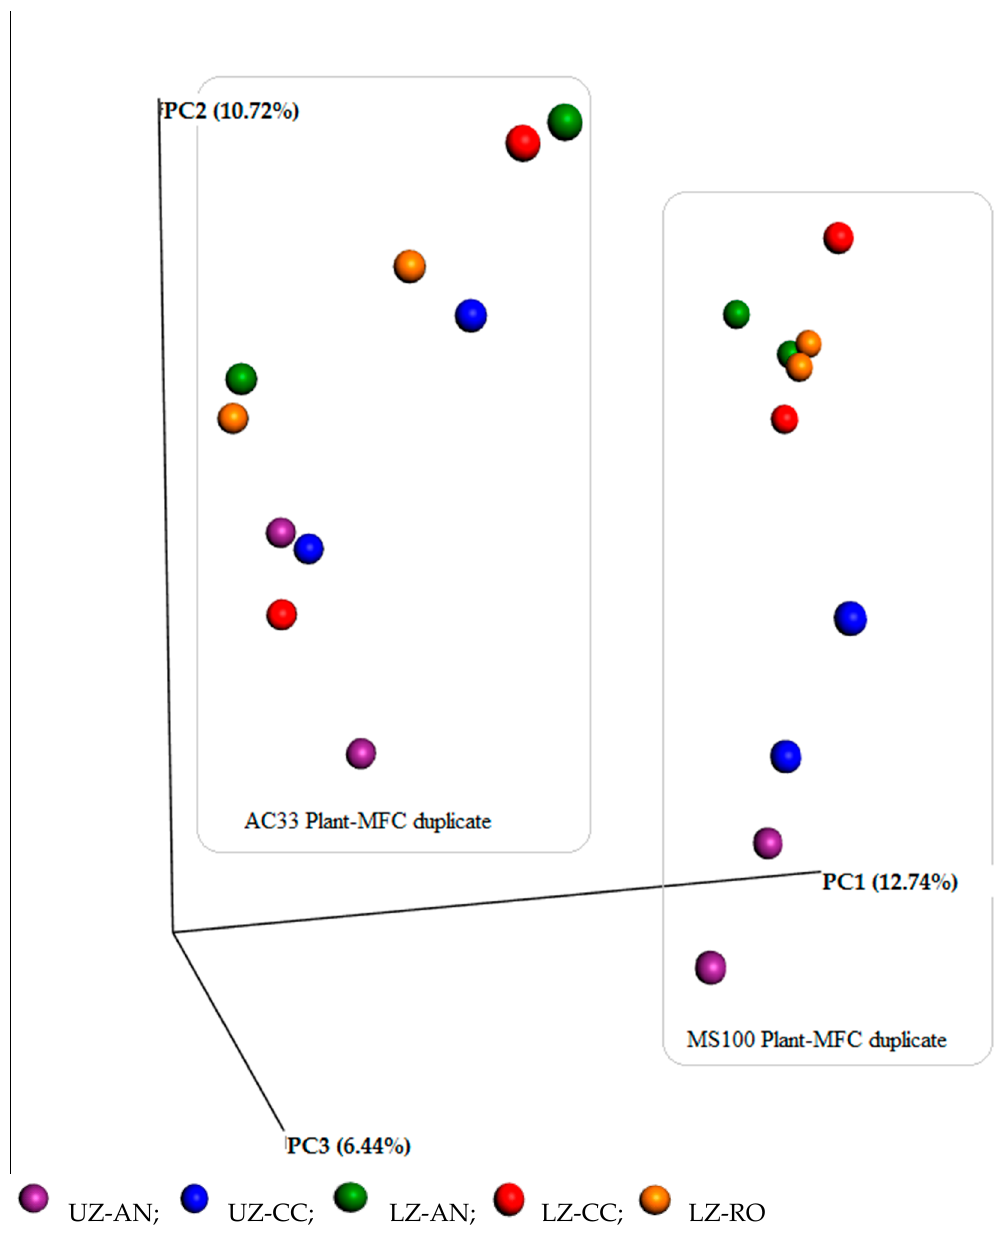
Figure 7. Unweighted UniFrac Principal Coordinates Analysis (PCoA) of Plant-MFC microbial Figure7. communities.